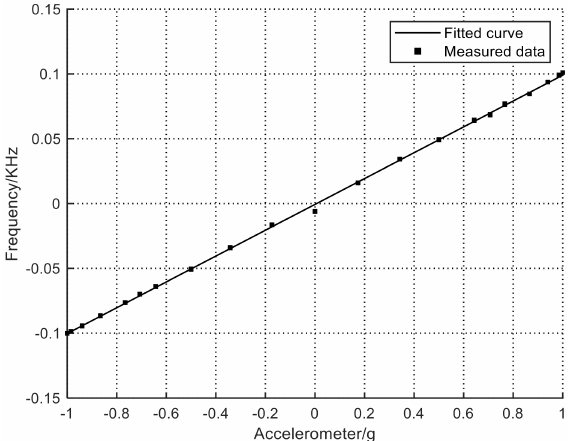
Figure 19. Sensitivity of the resonant